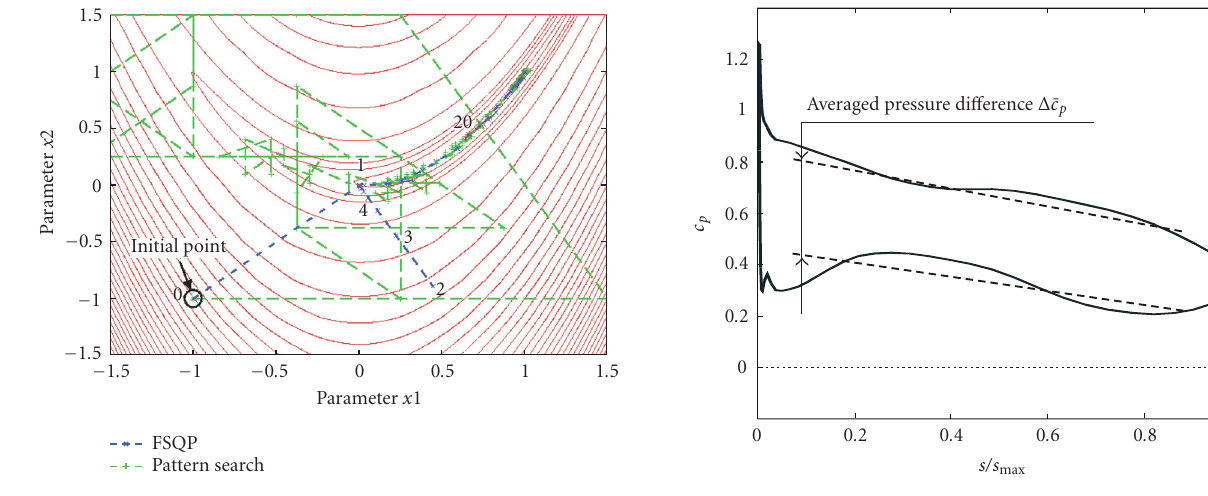
Figure 5: Smooth pressure